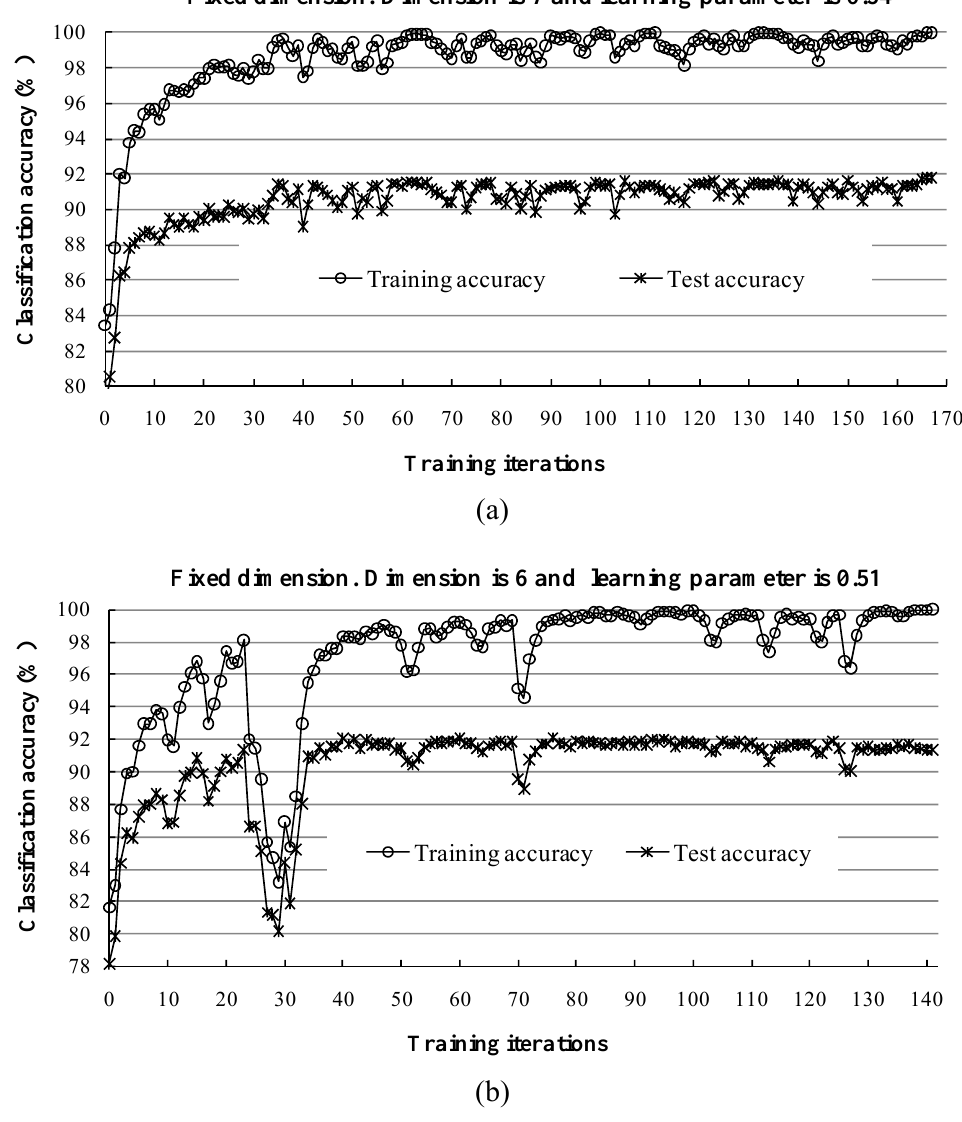
Figure 6. Plots of the accuracy rate vs. the number of iterations for the training and test samples. (a) Dimension of 7 with the learning parameter 0.54; the best test data accuracy of 91.79% was reached when the training iterations completed (at 167). (b) Dimension of 6 with the learning parameter 0.51; an accuracy of 91.34% was achieved when the training iteration completed (at 141). However, the best test data accuracy of 92.11% was reached at training iteration 76.